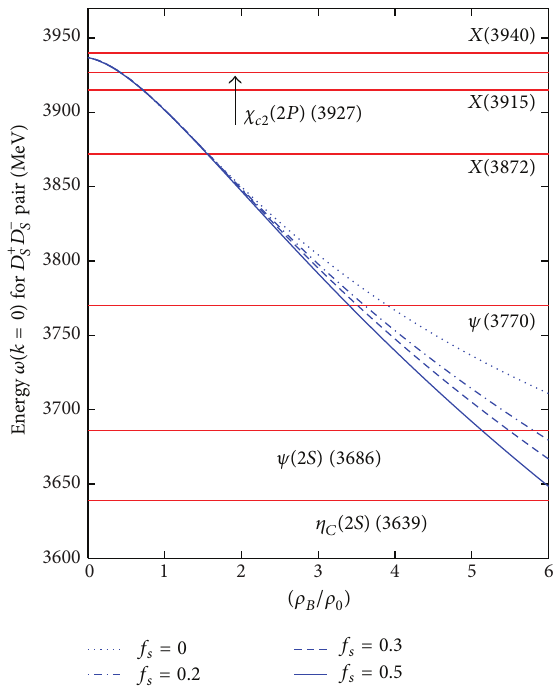
Figure 7: Mass of the 𝐷 + 𝑆 𝐷 − 𝑆 pair, compared against the (vacuum) masses of the excited charmonia states, at typical values of temper- ature ( 𝑇 = 100 MeV) and asymmetry ( 𝜂 = 0.5 ), for both nuclear matter ( 𝑓 𝑠 = 0 ) and hyperonic matter ( 𝑓 𝑠 = 0.2 , 0.3 , and 0.5 ) situations. The respective threshold density ( see text ) is given by the point of intersection of the two concerned